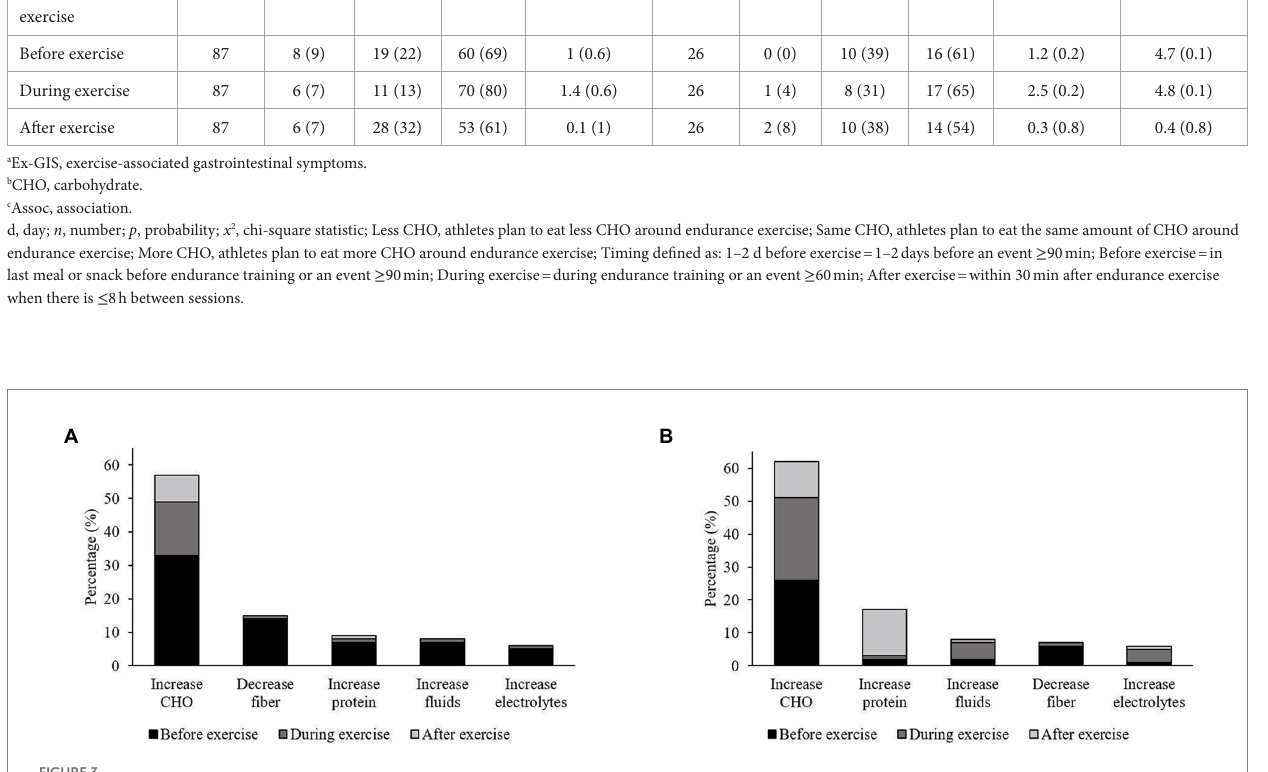
FIGURE 3 Five most commonly reported responses by endurance athletes with and without exercise-associated gastrointestinal symptoms (Ex-GIS) and the specific nutrition strategies applied (i.e., changes to usual eating habits or changes to the types of foods and drinks usually consumed) before (not further defined by athletes), during, or after endurance training or an event. CHO = carbohydrate. (A) , athletes with reported Ex-GIS; (B) , athletes without reported